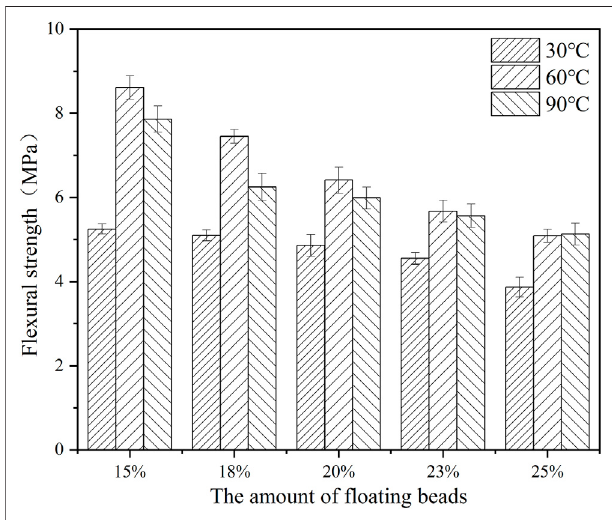
FIGURE 5 | Flexural strength of cement stones.